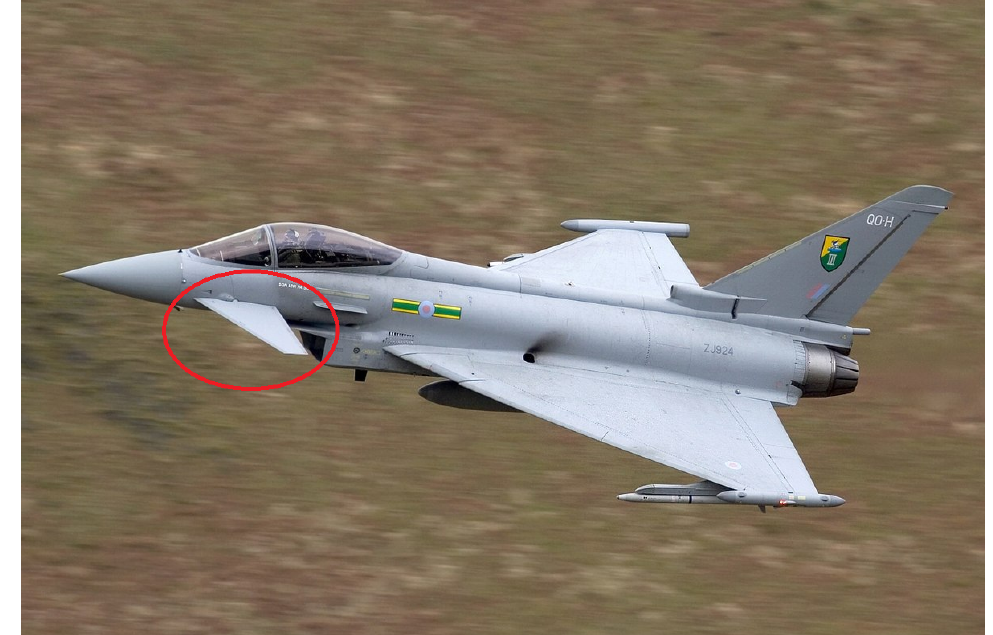
Figure 10. A canard of the Eurofighter Typhoon (highlighted with a red circle).